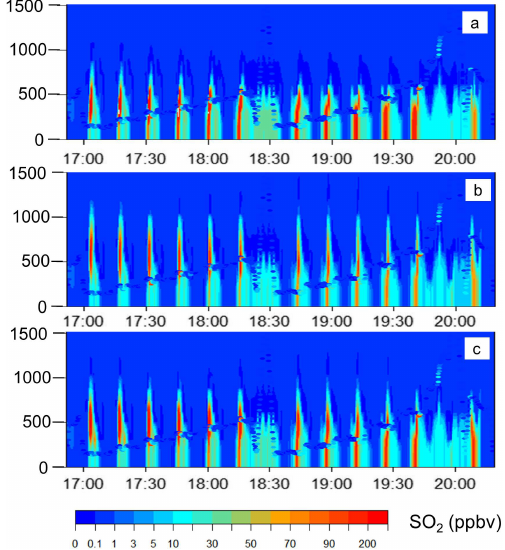
Figure 6. Model SO 2 profile along the aircraft path for flight 12: (a) 12-bin simulation (original plume-rise algorithm), (b) plume- rise simulation (revised plume-rise algorithm), and (c) hourly simu- lation (revised plume-rise algorithm combined with hourly data for volume flow rates and stack temperatures). Panels (a–c) show model predictions in the column of the aircraft trajectory as concentration contours – aircraft-observed values at the aircraft locations at the given time (in UTC) – are shown as coloured dots over-plotting the background